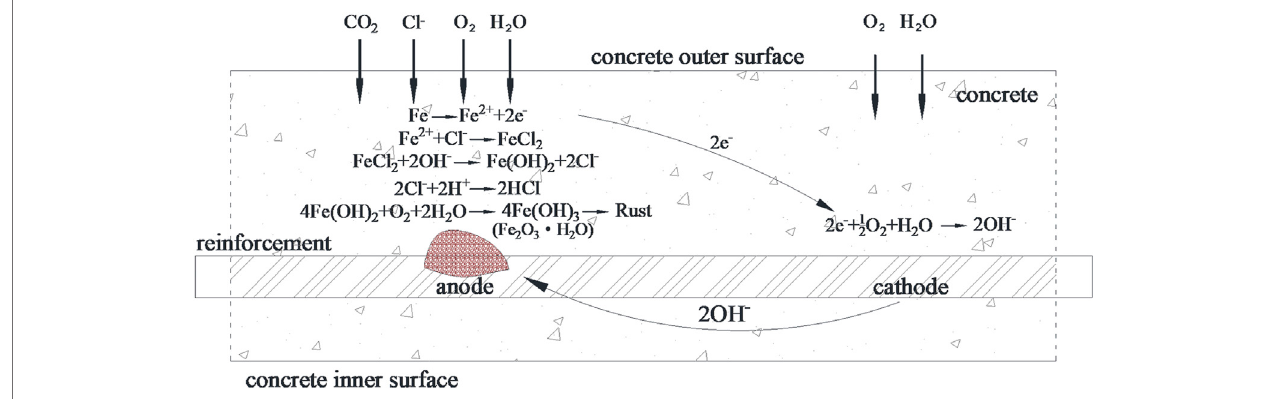
FIGURE 2 | Representation of the corrosion process of rebar in concrete and the electrochemical